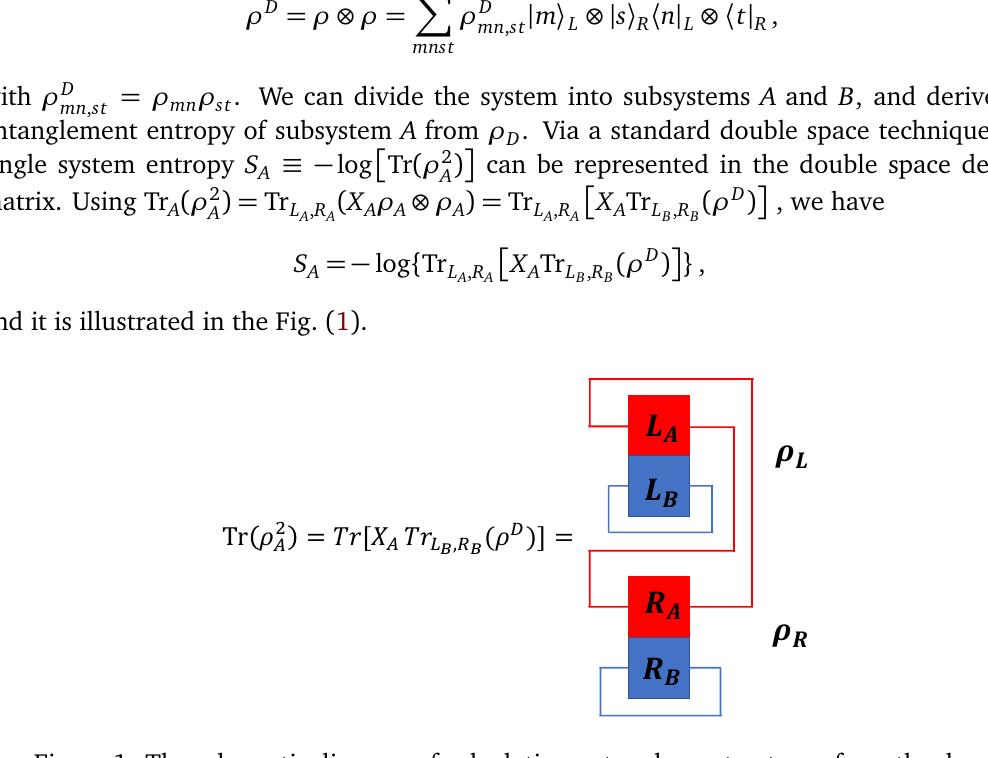
Figure 1: The schematic diagram of calculating entanglement entropy from the dou- ble state density matrix ρ D